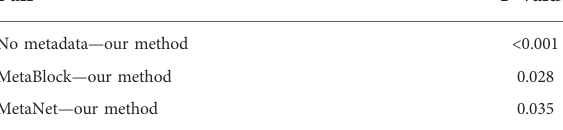
TABLE 3 Result of the Wilcoxon pair test for different methods.